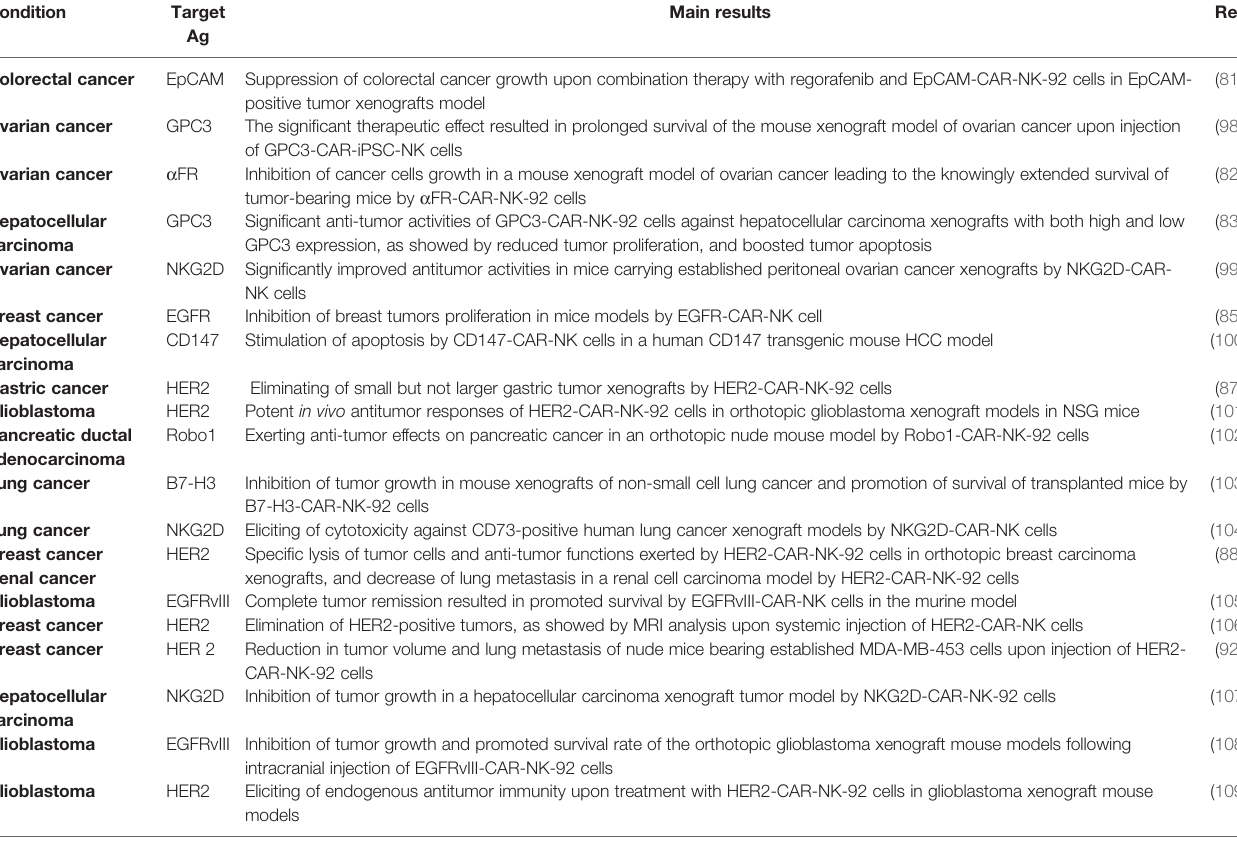
TABLE 2 | Overview of in vivo studies based on CAR-NK cell therapy for solid tumors.